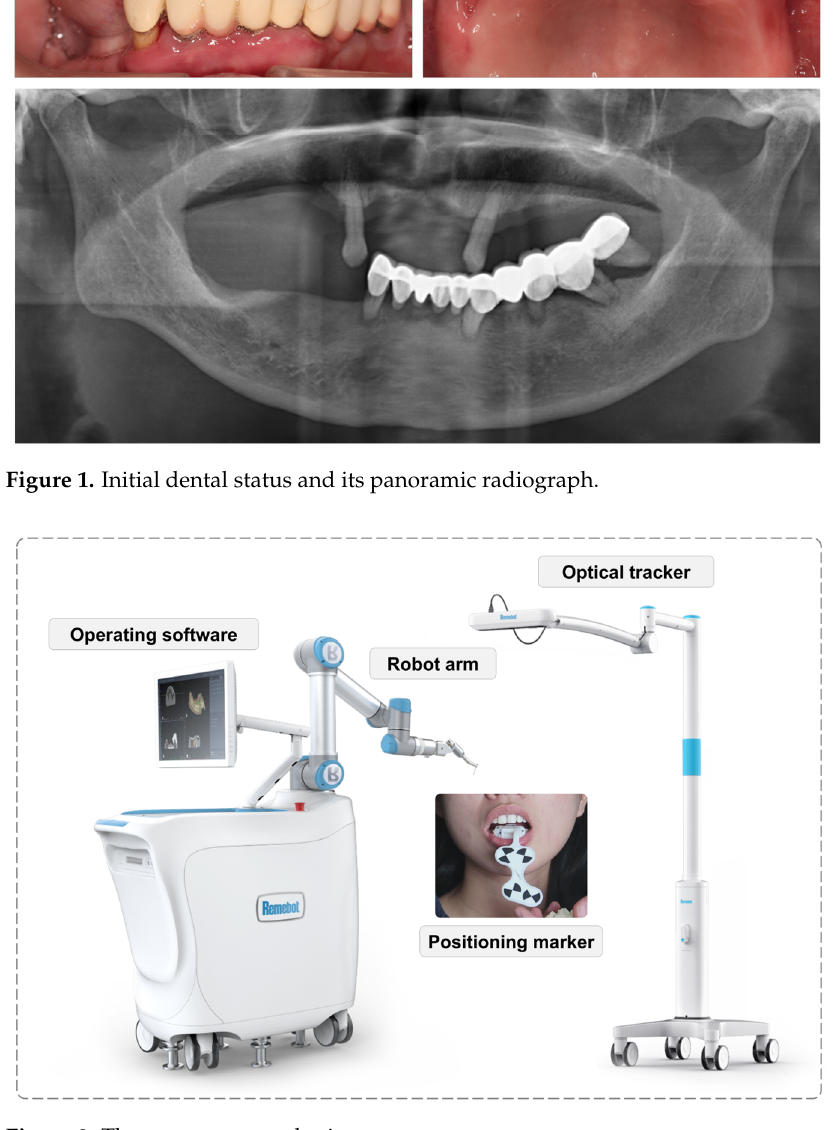
Figure 2. The autonomous robotic surgery system.